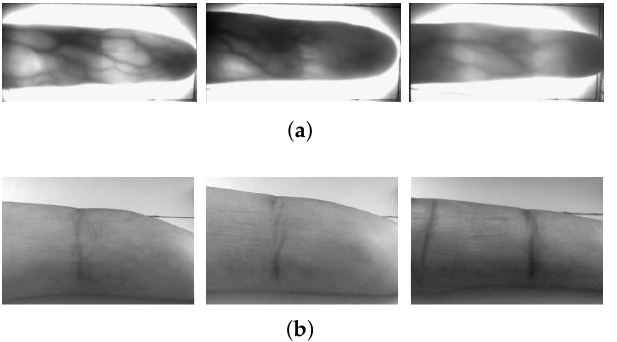
Figure 5. Sample images of PolyU-DB. ( a ) FV images and their corresponding ( b ) IKP images.